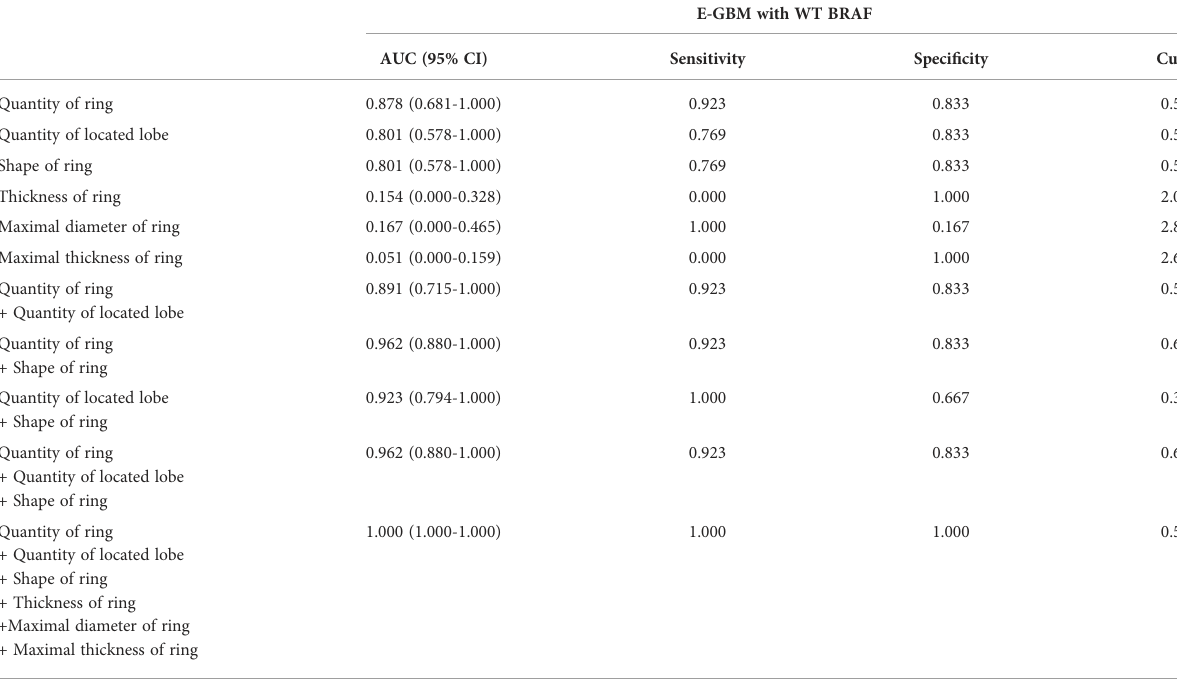
TABLE 6 Evaluation of differential diagnosis ef fi cacy for MUT BRAF and WT BRAF in